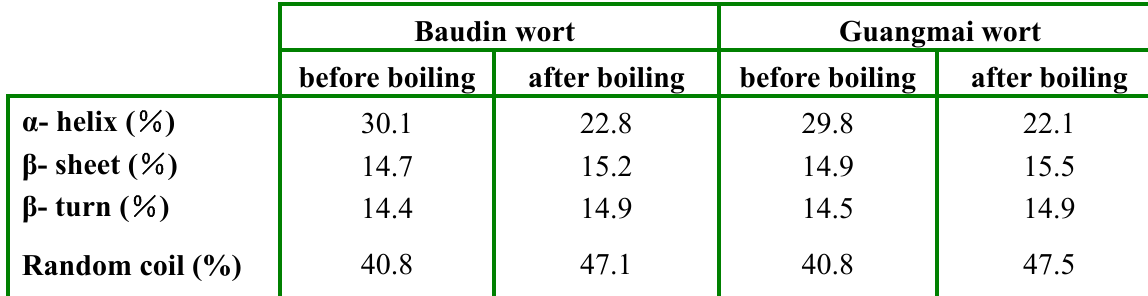
Table 4 . Comparison of secondary structure contents of wort protein before and after boiling between the two varieties a